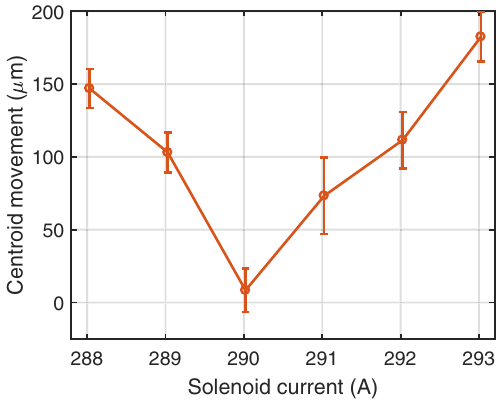
FIG. 8. One example of beam movement at the observation screen when the laser spot is moved by 0.5 mm vertically at the cathode in